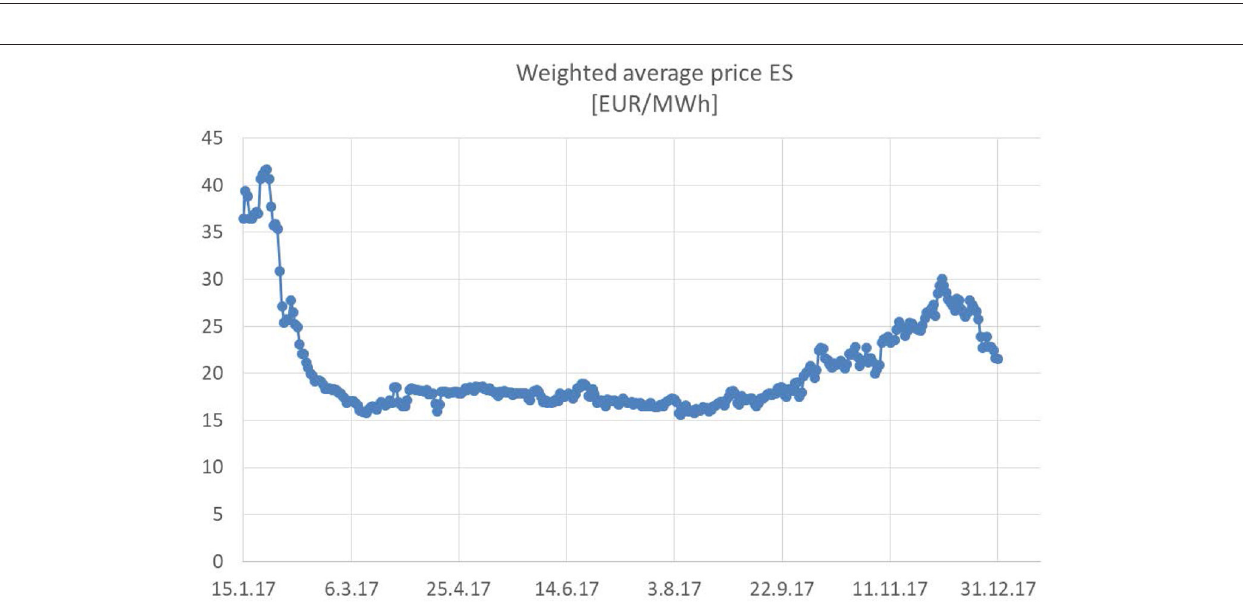
FIGURE 2 | Scheme of a Hydrogen station based on methane decarbonization.